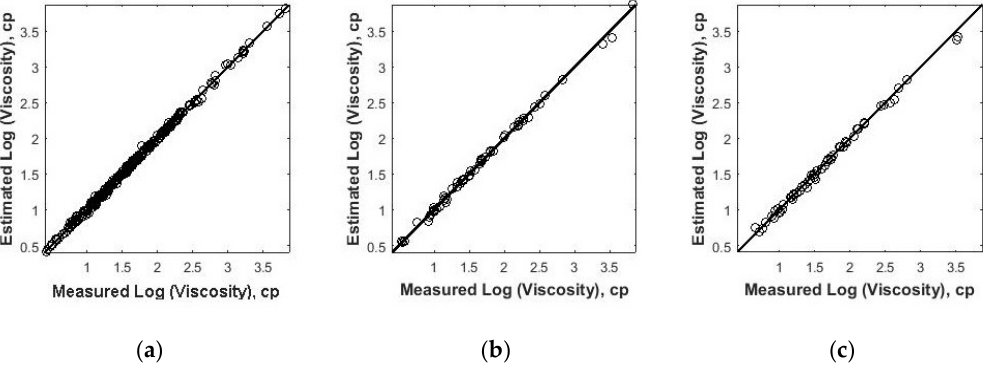
Figure 6. Comparison of the measured and estimated data for Flopaam TM 3630S. ( a ) Training. ( b ) Validation. ( c ) Test.